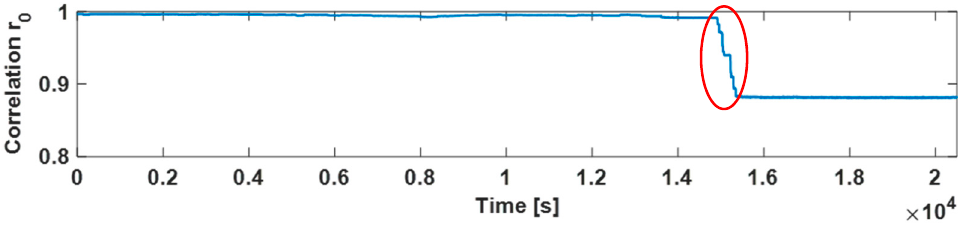
Figure 6. Evolution of r 0 for a flow rate of 1 L/h.